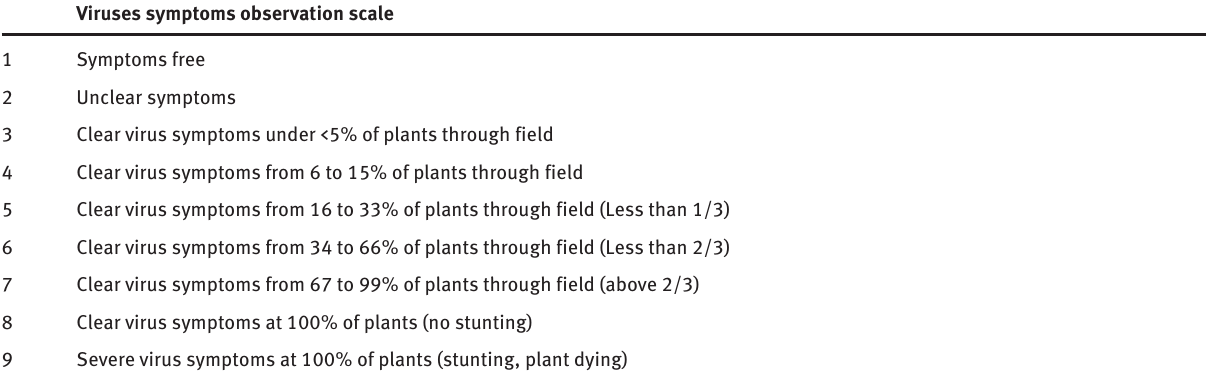
Viruses symptoms observation